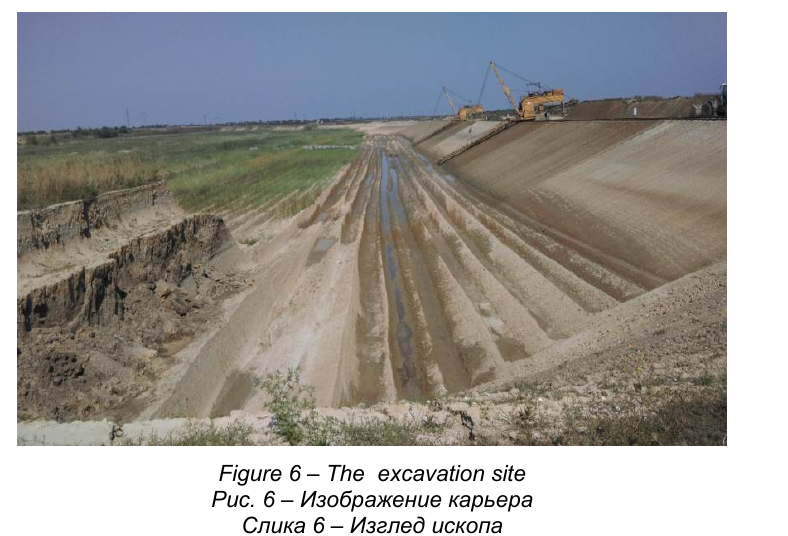
Figure 6 – The excavation site Рис . 6 – Изображение карьера Слика 6 – Изглед